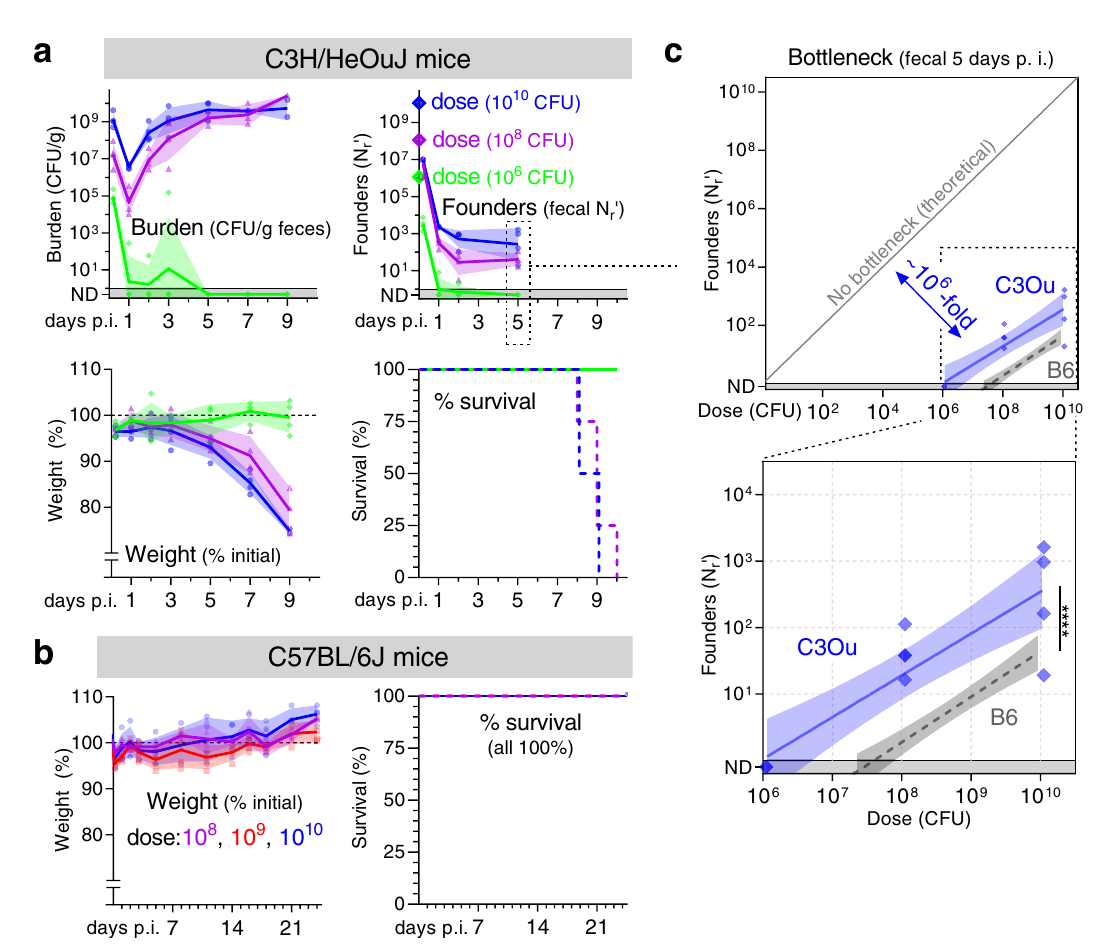
Fig. 5 | Host genotype impacts the bottleneck to C. rodentium colonization. C3H/HeOuJ ( a ) or C57BL/6J ( b ) mice were inoculated with doses ranging from 10 6 to 10 10 CFU of STAMP-CR253. The C. rodentium population was monitored in the feces (geometric means and standard deviations; ND not detected counted as 0.5) and animal health assessed by weight loss (percent compared to pre-inoculation; arithmetic means and standard deviations) and body condition. For survival, lines